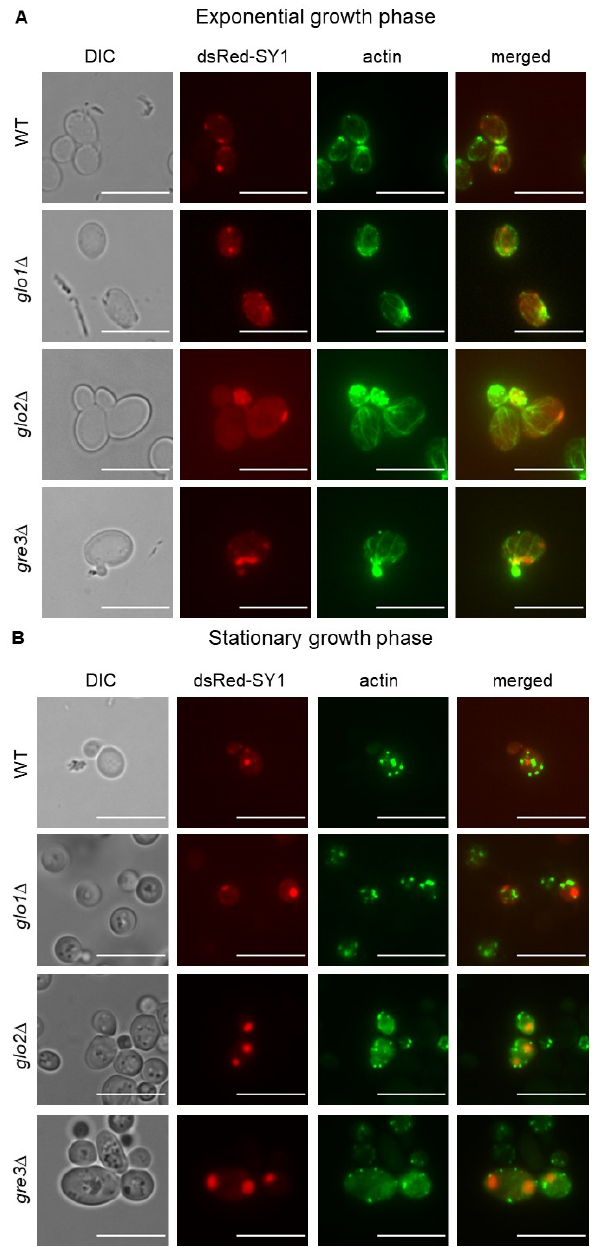
Figure 8. Microscopic analysis of actin cytoskeleton organisation and SY1 inclusion localisation in dsRed-SNCAIP -expressing S. cerevisiae strains during exponential ( A ) and stationary ( B ) growth phase. The scale bars represent 10 µ m. SY1 =